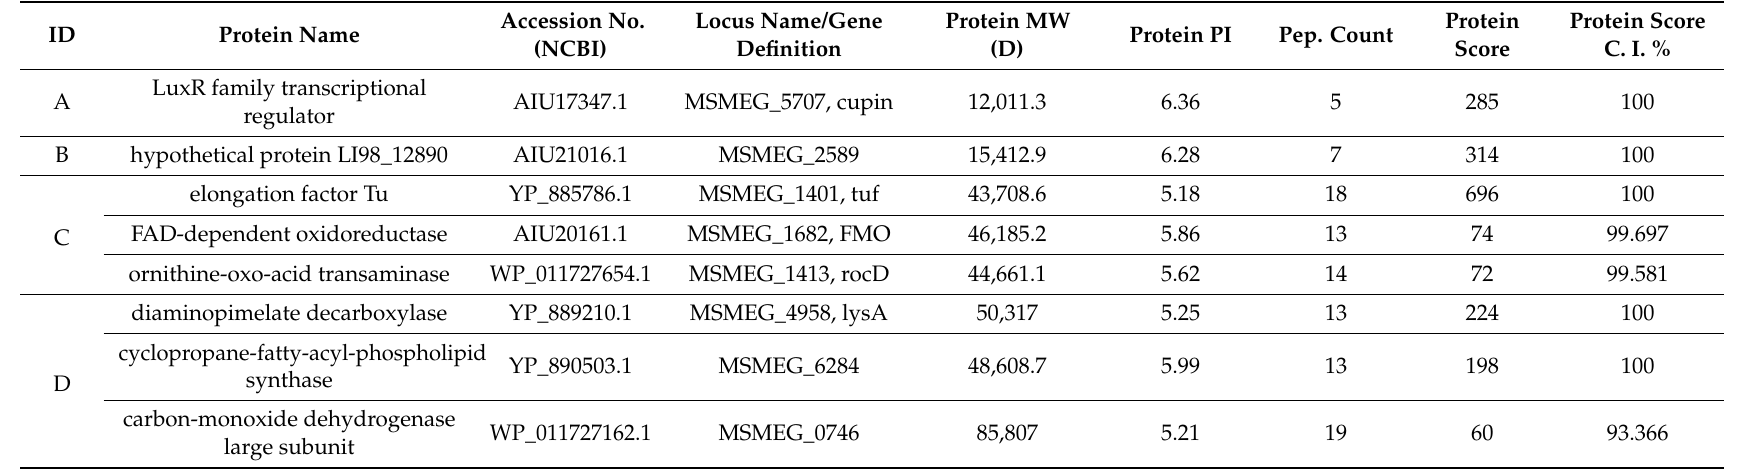
Table 2. The list of the putative interaction partners of Tb -DdlA in Msm detected by MS/MS. A, B, C and D were the corresponding bands from the silver-stained polyacrylamide